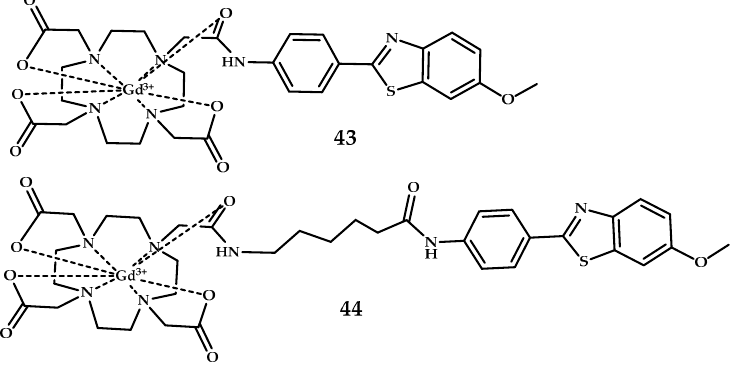
Figure 12. DO3A–PiB–based Gd 3+ coordination compounds 43 and 44 , designed for MRI visualization of A β plagues.